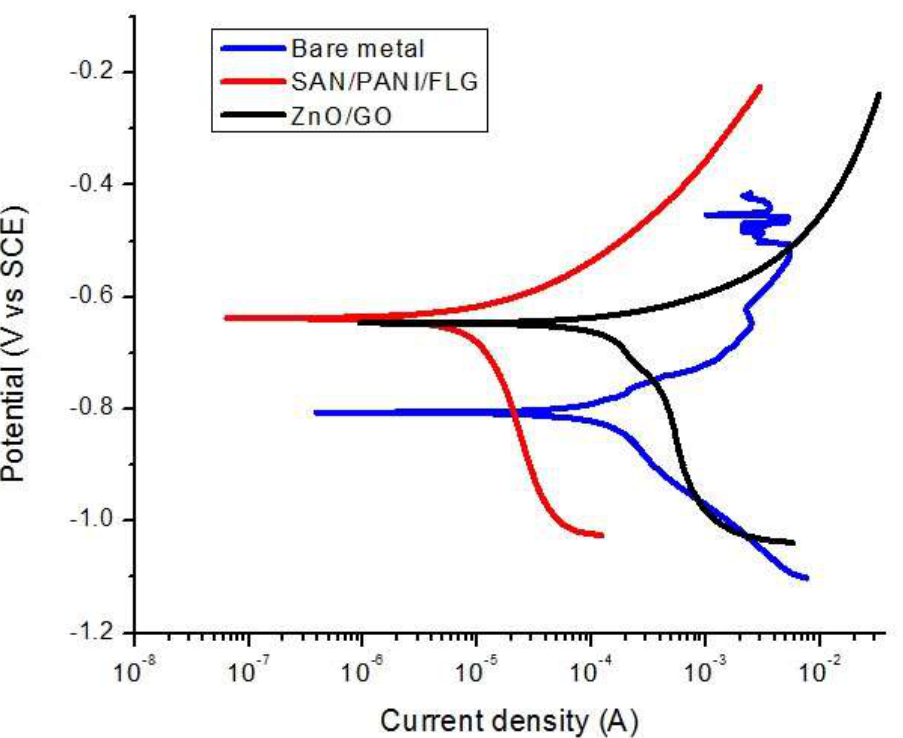
Figure 9. ’E-log i’ curves-bare and coated samples in (crude oil produced water).